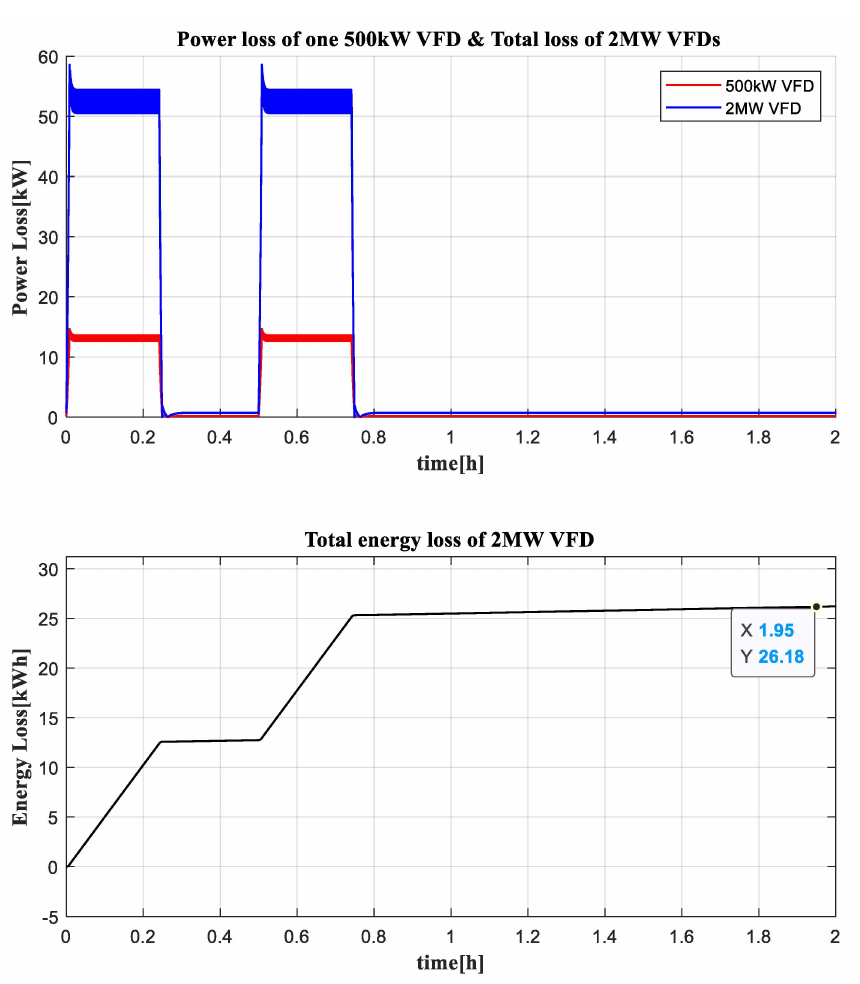
Figure 25. Simulation results for the power and energy loss of 1 MW VFD inverter #1, #2.